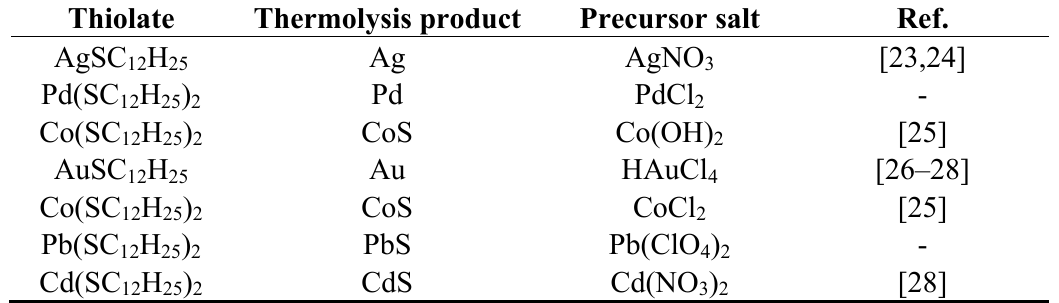
Table 1. Some characteristics of metal thiolates used for the nanocomposite film